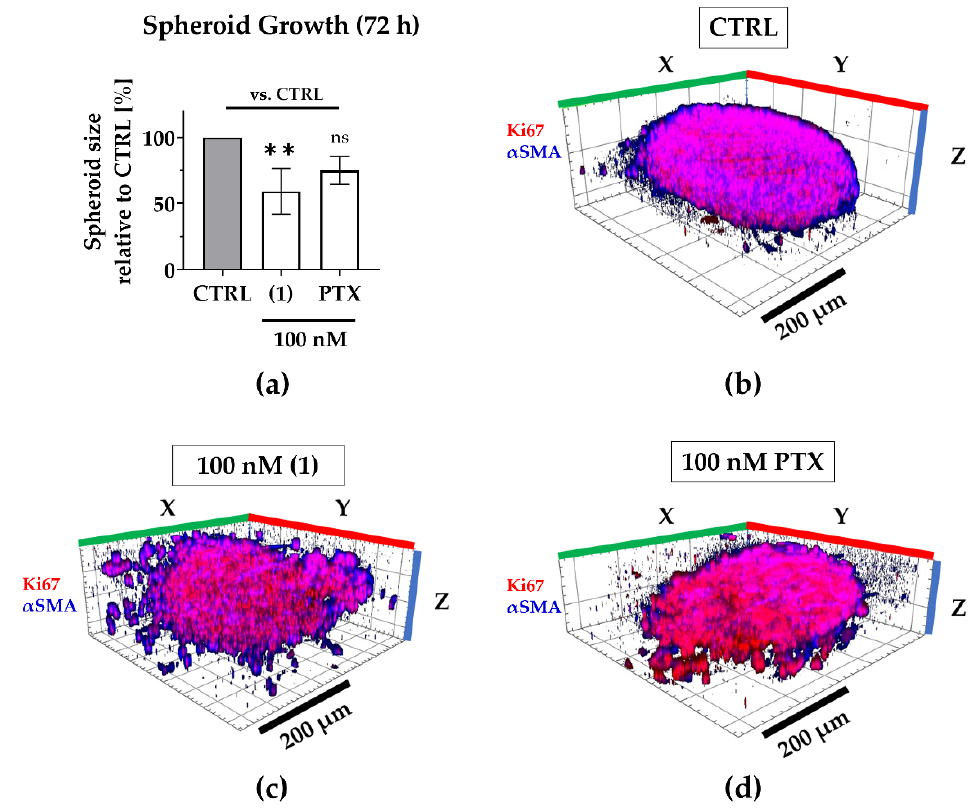
Figure 5. Compound ( 1 ) exhibits superior anti-growth effects compared to paclitaxel. The TNBC co-culture spheroids were grown for 72 h without (CTRL) or with 100 nM ( 1 ), 100 nM paclitaxel (PTX). ( a ) Post-treatment, the spheroid size was determined based on the spheroid area that was measured in brightfield images. The spheroid size was normalized to the mean spheroid size of CTRL (100%). Statistical significance vs. CTRL was calculated with one-way ANOVA (ns = not significant, ** p < 0.01). Columns represent the mean ± SD ( n = 3). ( b – d ) Spheroids were immunologically stained for Ki67 (red; MDA-MB-231) and α SMA (blue; CAFs). Whole 3D spheroids were illustrated based on z-stacked fluorescence images using Zen (Zeiss, Oberkochen, Germany; blue edition, version 2.3). Scale bar: 200 µ